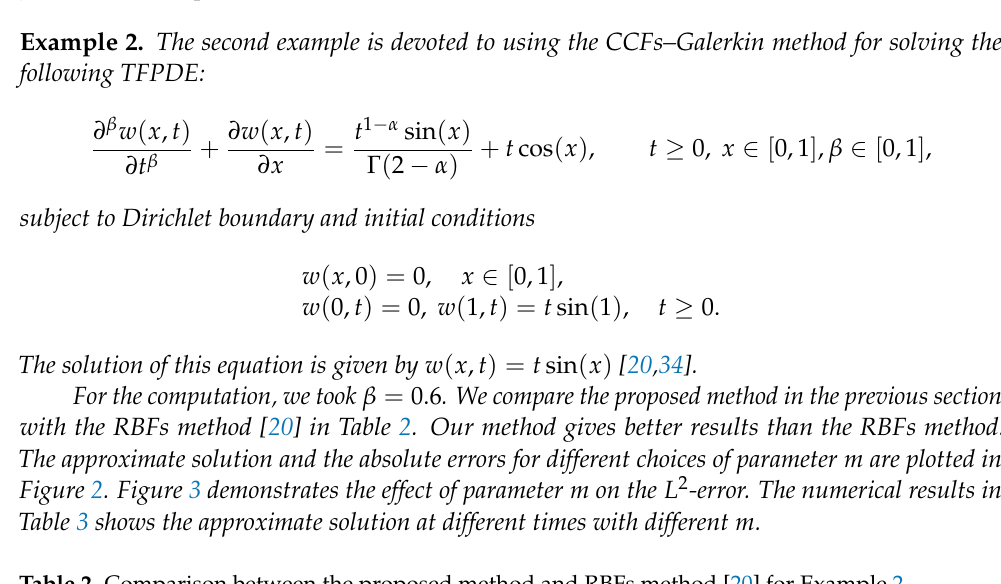
Table 2. Comparison between the proposed method and RBFs method [20] for Example 2.